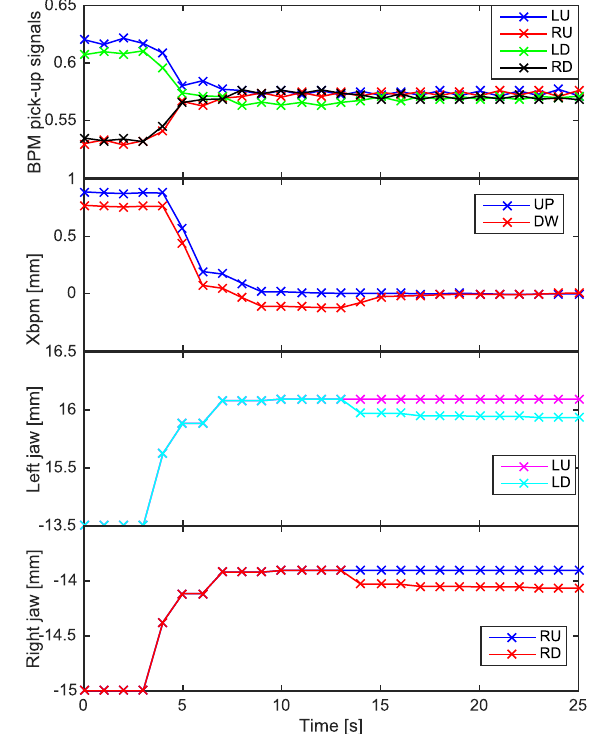
FIG. 4. Example of a BPM-based alignment of the TCSP.A4R6.B1, showing the left-up (LU), left-down (LD), right-up (RU) and right-down (RD) jaw corner positions and electrode signals, as well as the upstream (UP) and downstream (DW) beam positions measured relative to the